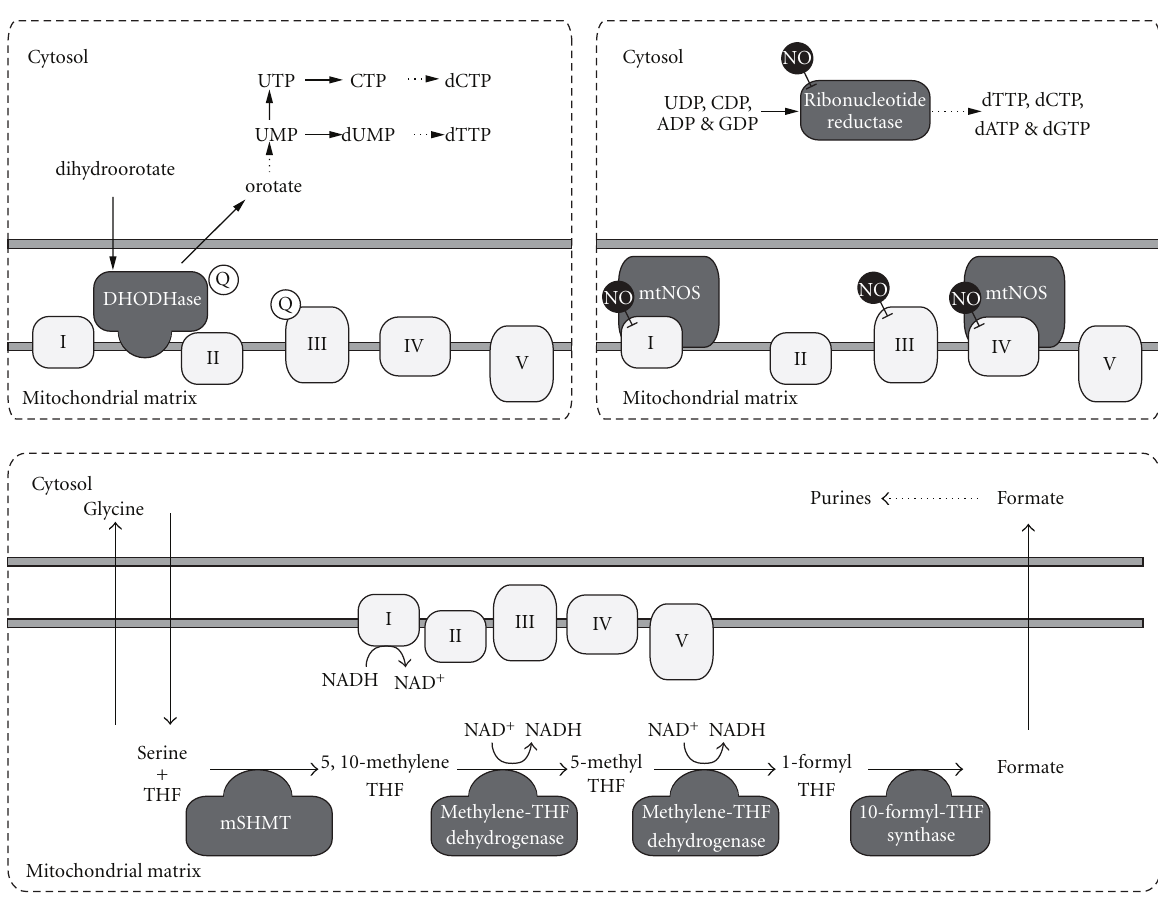
Figure 1: Overview of metabolic pathways responsible for nucleotide metabolism that can be a ff ected by mitochondrial dysfunction. The illustration depicts the outer and inner mitochondrial membrane. Complexes of the electron transport chain are illustrated with boxes marked with numerals I-IV. Boxes marked with V depict ATP synthase. Darkened boxes illustrate enzymes of interest. Upper left: Dihydroorotate (DHODHase) is an integral enzyme in the de novo synthesis of pyrimidines. The enzyme is located in the inner mitochondrial membrane and its activity is dependent on an active electron transport chain. Upper right: Mitochondrial nitric oxide synthase (mtNOS) creates NO in a Ca 2+ dependent reaction. The enzyme is located in the inner mitochondrial membrane where it interacts with both complexes I and IV of the electron transport chain. The activity of mtNOS is linked to the mitochondrial membrane potential. NO has the potential to inhibit the activity of Complexes I, III, and IV, but also ribonucleotide reductase in the cytosol. Lower: Illustration of the mitochondrial production of one-carbon units and mitochondrial export of formate. See text for